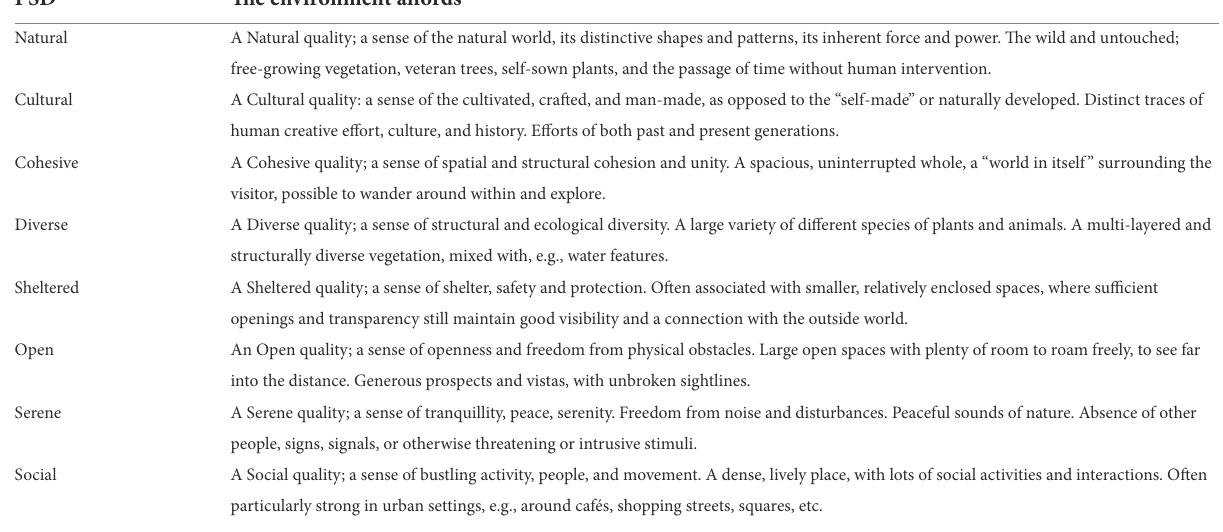
TABLE 1 Eight perceived sensory dimensions, understood as complementary pairs of opposing qualities (following Stoltz and Grahn, 2021). PSD The environment